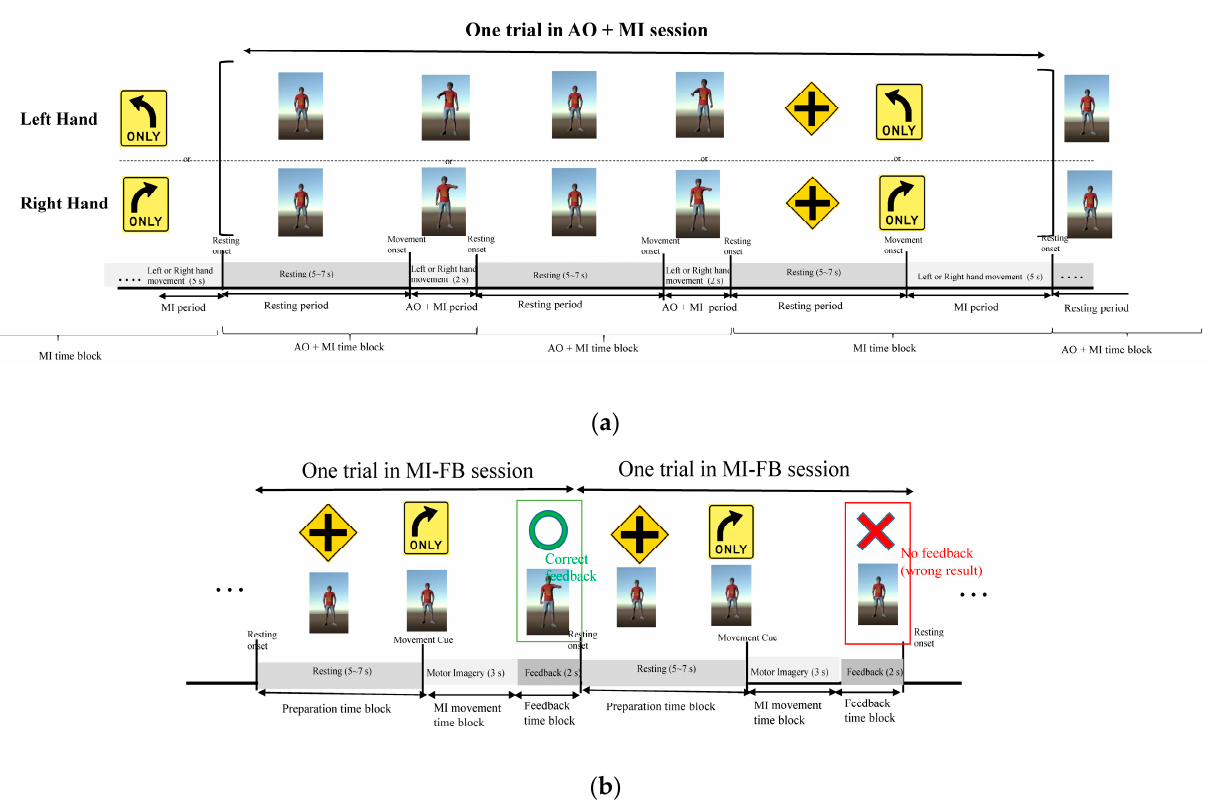
Figure 2. The experimental paradigms of the AO + MI and the MI - FB sessions. Subjects were asked to imagine they were looking into a mirror and the virtual character was the reflection im- age of themselves. ( a ) The paradigm of the AO + MI session, including two AO + MI time blocks and one MI time block in each trial; ( b ) the paradigm of the MI session, including one preparation time block, one MI movement time block, and one feedback time block. one MI movement time block, and one feedback time